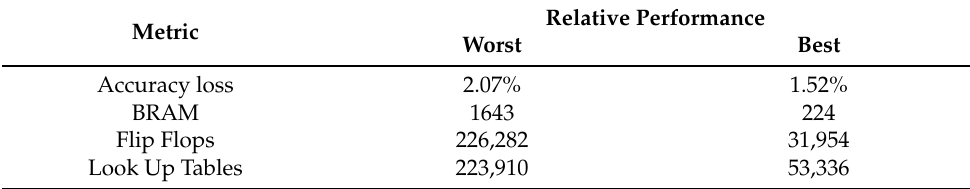
Table 3. Relative performance for radar plots in Figure 7.